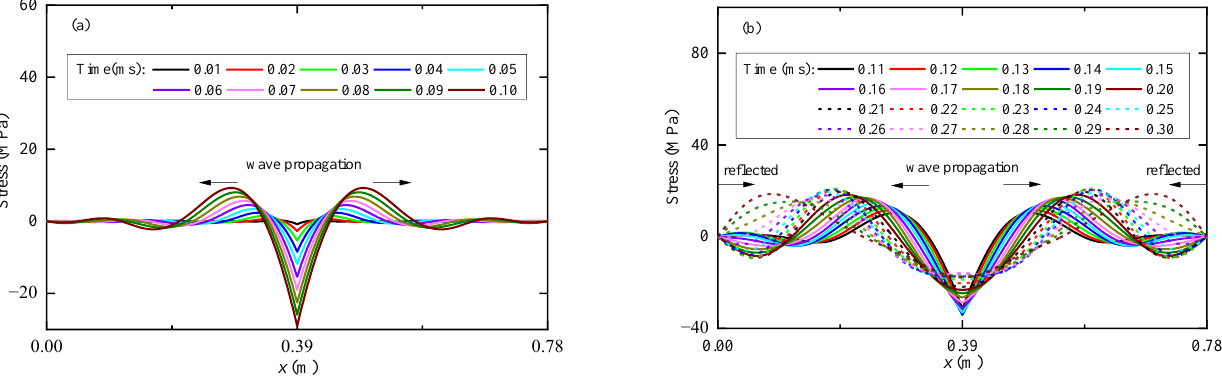
Figure 6. Transient stress distribution along the beam of the first impact of H = 50 mm, with Stronge contact model: ( a ) loading phase; ( b ) unloading phase and post-impact phase.